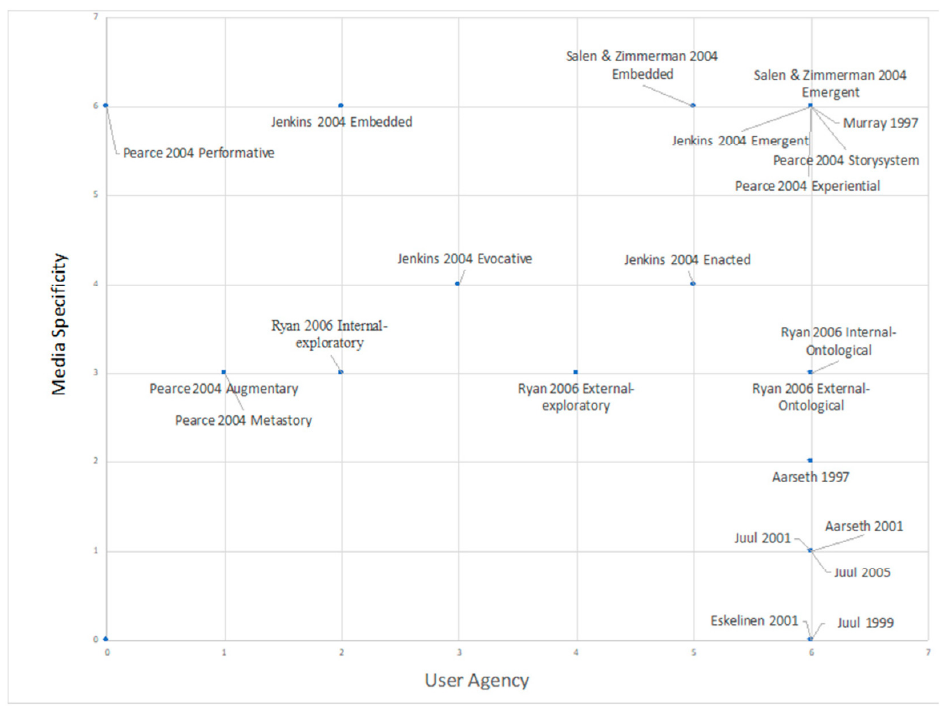
Figure 1. Spatial mapping of different ontological positions onto an interactive narrative (Koenitz, 2018).